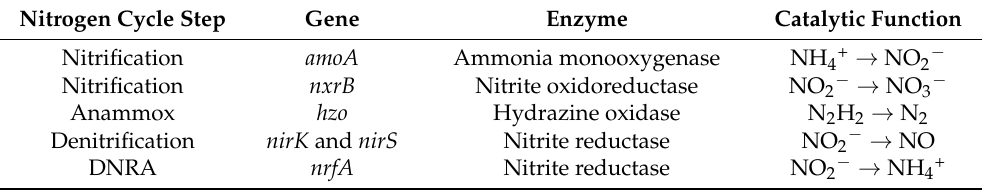
Table 2. Enzymes encoded by genes for nitrification, anammox, denitrification and DNRA and their specific catalytic